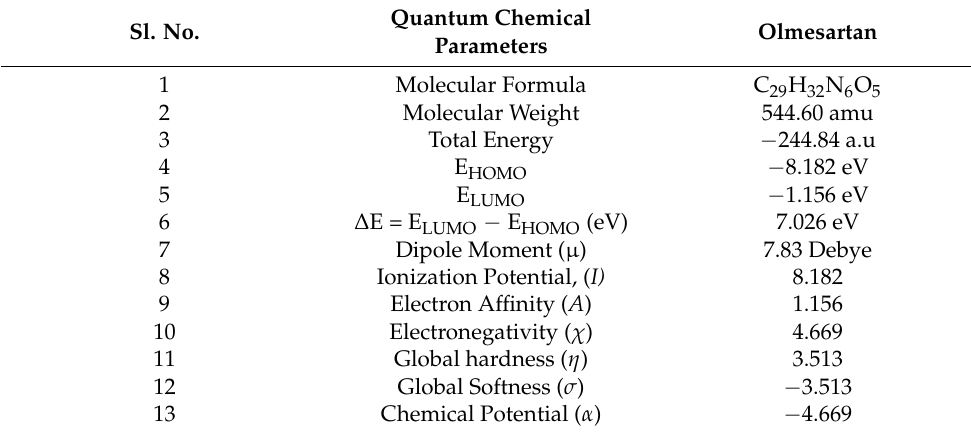
Table 2. Quantum chemical parameters of olmesartan molecules. Sl. No.